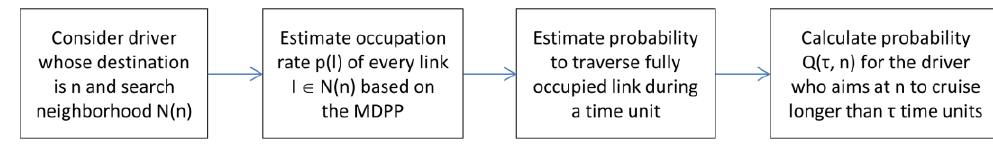
Figure 3. Flow chart of the algorithm for estimating cruising time distribution.